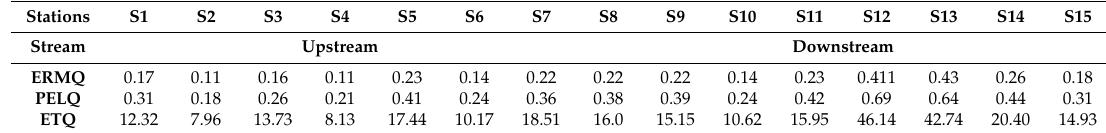
Table 2. Sediment quality guidelines and environment toxicity quotient.